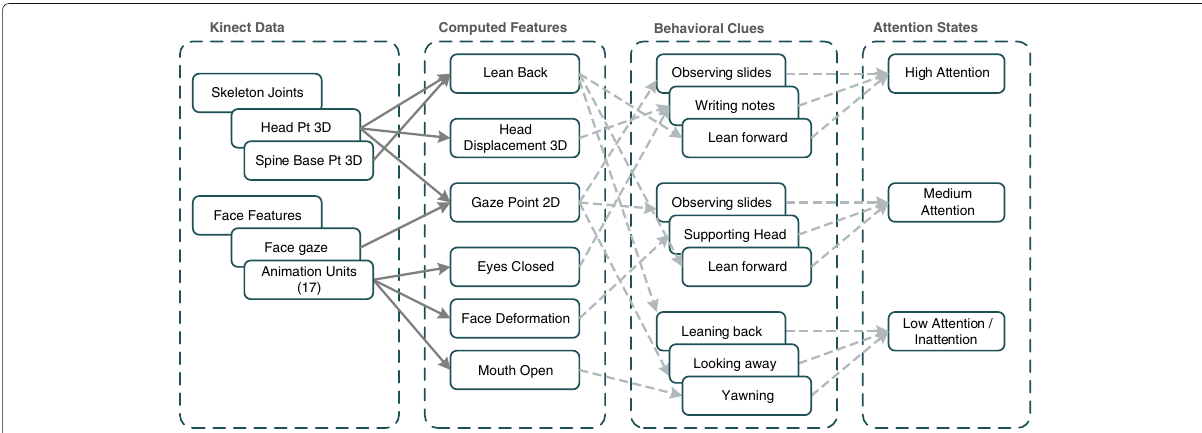
Fig. 3 Relation between computed features based on Kinect signals and the observable behavioral cues. High correlation between computed feature and the behavior is shown as dotted line ˆ f j , u ( t ) by using Gaussian filter of versions of feature signals width 11 s. Normalized and smoothed feature signals are shown in Fig. 5.